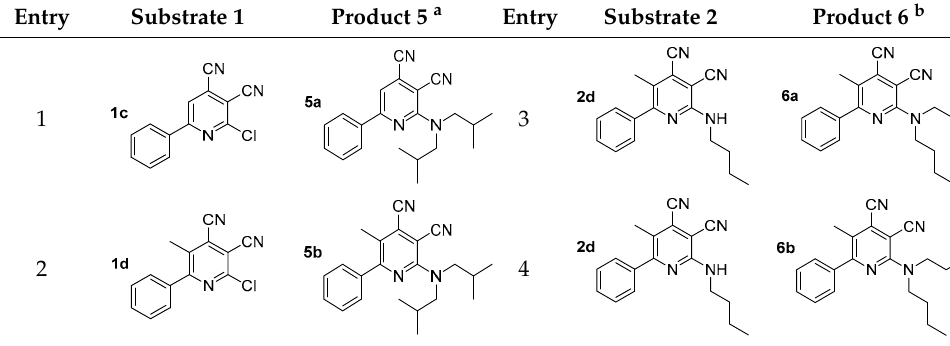
Table 4. Structure of starting compounds 1 and isolated products 5 and 6.